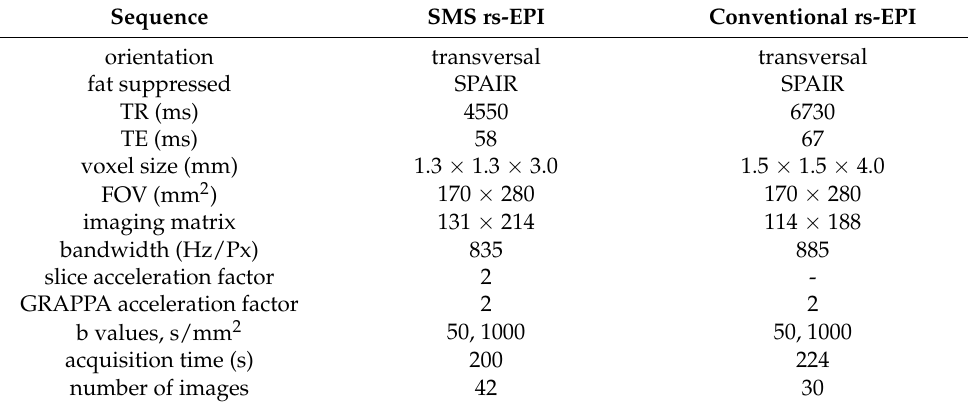
Table 1. Imaging parameters of SMS rs-EPI sequence and conventional